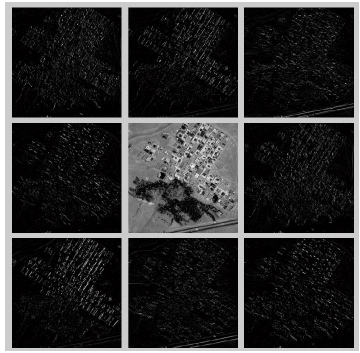
Figure 2. Sample HOG with eight directions for